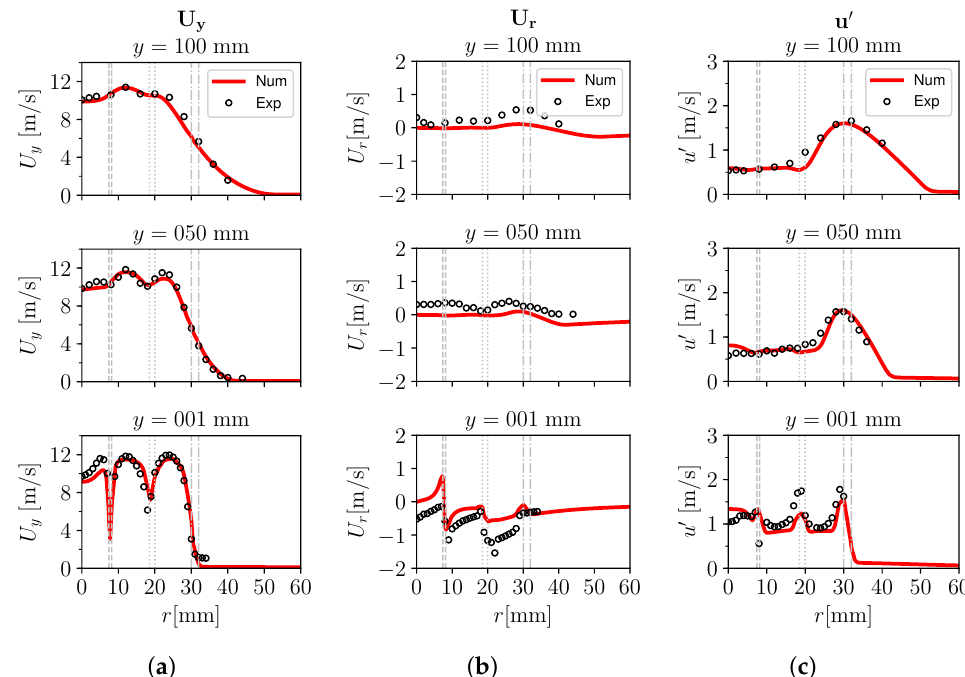
Figure 6. Case A-i2: radial distributions of mean axial velocity U y ( a ); mean radial velocity U r ( b ); and mean turbulence intensity u (cid:48) ( c ); computed at various axial positions y in comparison with experimental data. Hereafter, following the increase of r , the vertical grey dashed, dotted and dashed- dotted lines correspond to the radial positions of the inner and outer walls of the pilot, slot 1 and slot 2,